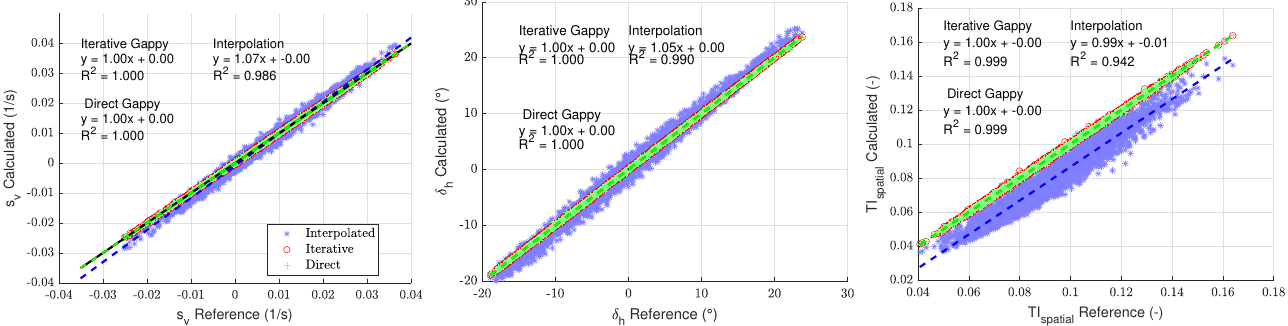
Figure 13. Comparison of s v , δ h and TI Spatial calculated from the reconstructed data for the CBL case with G =